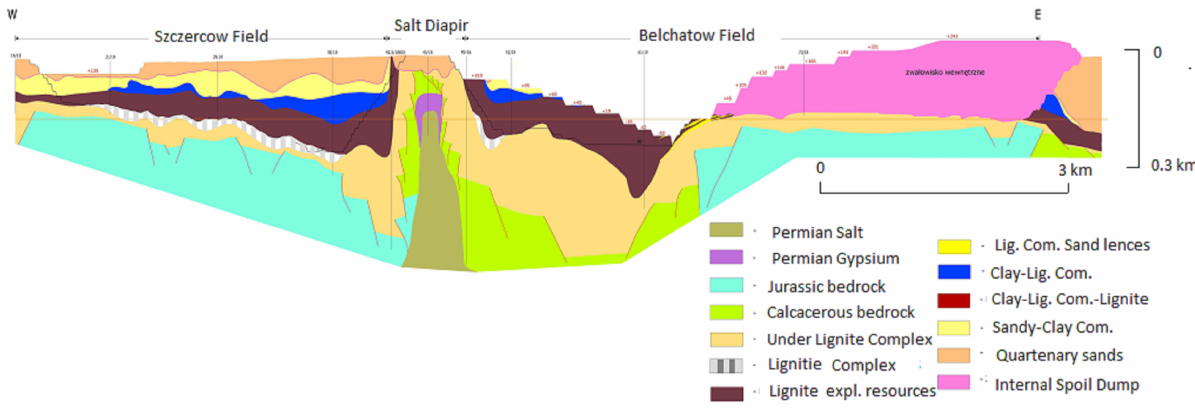
Figure 9. Geological WE cross-section of Belchatow and Szczercow Fields.